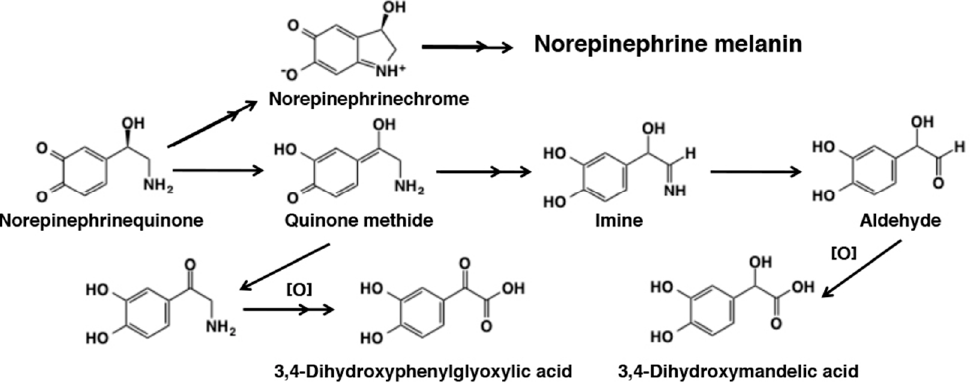
Figure 32. Reaction norepinephrinequinone [186]. The quinone methide pathway leads to the production of 3,4-dihydroxymandelic acid (DOMA), 3,4-dihydroxybenzaldehyde (DHBAld), 3,4- dihydroxybenzoic acid (DHBA), and 3,4-dihydroxyphenylglyoxylic acid. DHBAld and DHBA arise from DOMA (see Figure 17). Another pathway leads to the production of norepinephrine melanin through norepinephrinechrome.